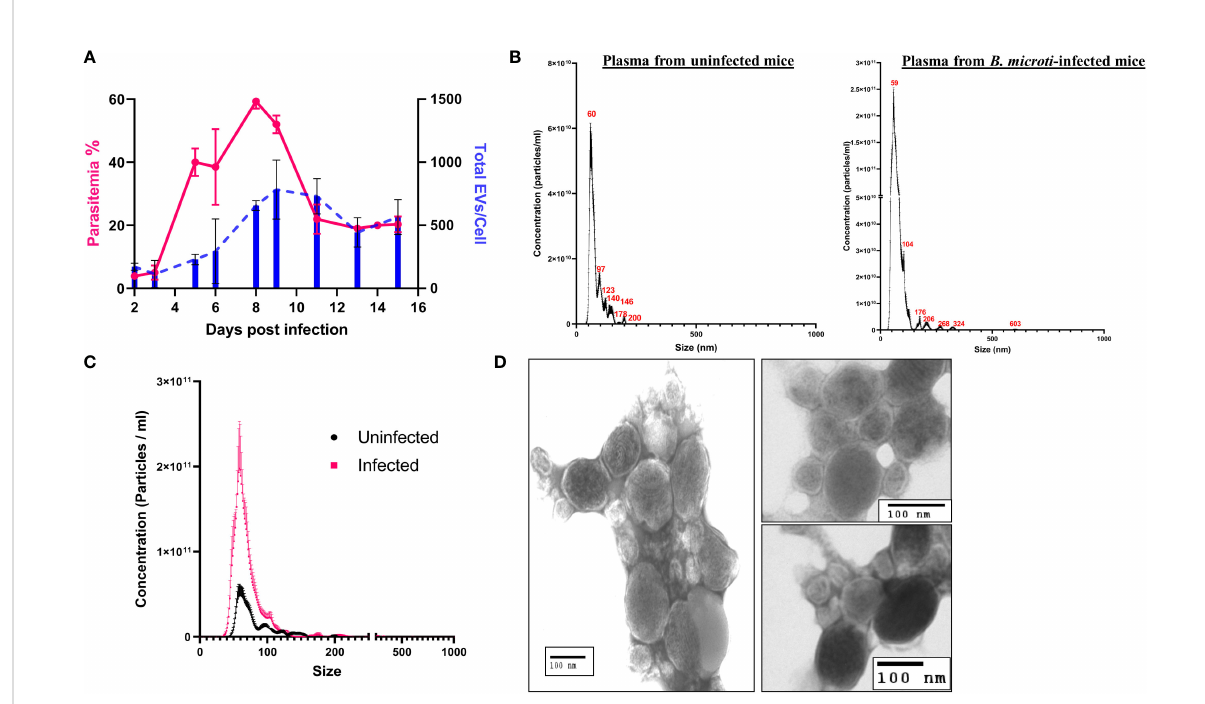
FIGURE 2 Characterization of extracellular vesicle (EV) derived from the plasma of control uninfected and B. microti – infected mice. EVs present in the plasma of uninfected and B. microti – infected mice were used for the analysis. (A) Comparison of total EVs/red cell (blue) with parasitemia (pink) and days post infection (x-axis) reveals that as parasitemia increases, there is an increase in the number of EVs, which peaks with a peak in parasitemia. As parasitemia begins to fall around day 12, the number of EVs/RBCs also decreases (n = 3 mice). (B) Nanoparticle tracking analysis in uninfected and B. microti – infected mouse plasma reveals the size distribution of EVs. As evident, most of the EVs in both sample sets were in the range of 60 – 120 nm. iRBCs showed a wider distribution of size of EVs. (C) A direct comparison between EVs from uRBCs and iRBCs (day 6 post invasion) in the mouse model. As evident, iRBCs showed a ~5-fold increase in EVs as compared with plasma from uninfected mouse. (D) EVs were enriched from mice infected with B. microti using the protocol detailed under Methods and visualized using transmission electron microscopy. A heterogeneous population of EVs with respect to size was shown, which is concurrent with the nanoparticle tracking analysis shown in (B)